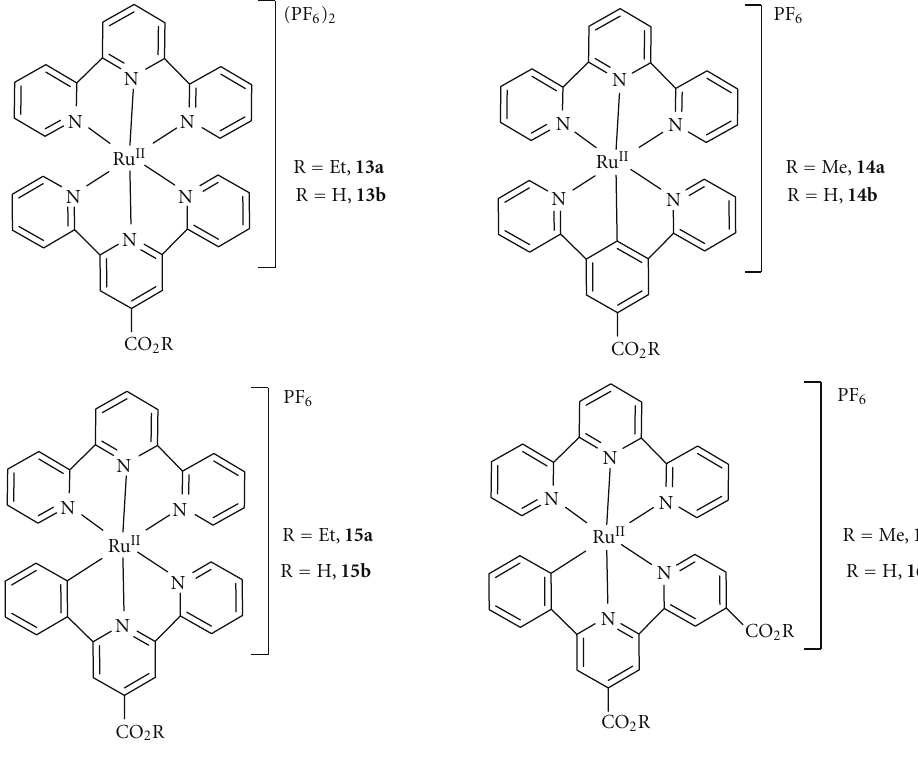
Figure 32: Molecular structures of 13–16 (taken from [56]).